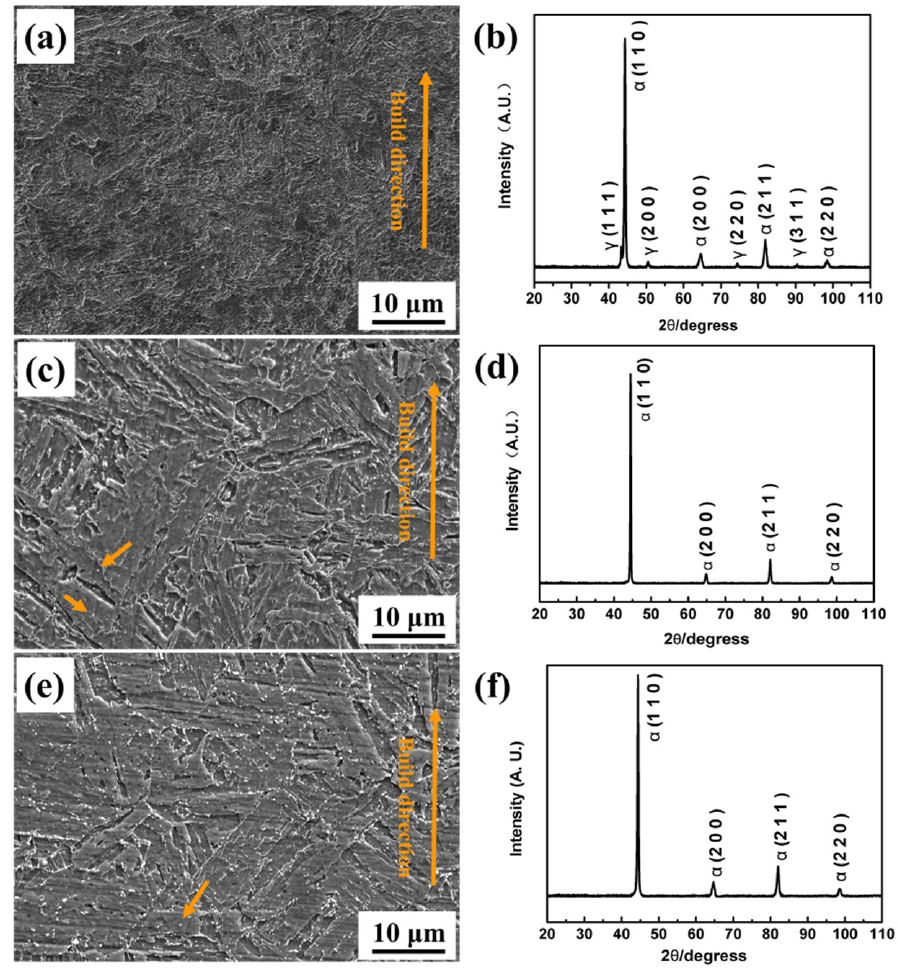
Figure 3. SEM images of the morphology of 17-4PH high-strength steel: ( a ) SLM-processed; ( c ) heat-treated in solution at 940 °C; ( e ) heat-treated in solution at 990 °C. XRD patterns of 17-4PH high-strength steel: ( b ) SLM-processed; ( d ) heat-treated in solution at 940 °C; ( f ) heat-treated in solution at 990 °C.